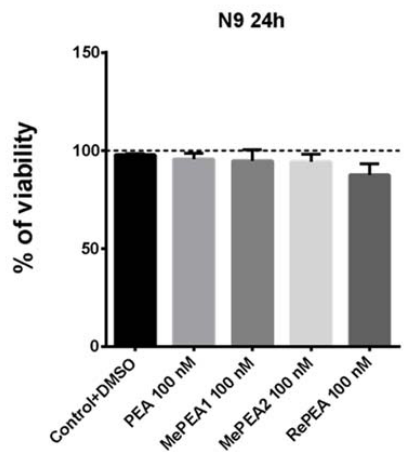
Figure 8. Cell viability in N9 murine microglial cells incubated for 1 h with 100 nM PEA and its analogues (MePEA1, MePEA2, RePEA). Then, medium was replaced with fresh IMDM supplemented with 5% FBS. Cell viability was quantified after 24 h. Data are presented as mean ± S.E.M. ( n = 3 independent experiments).